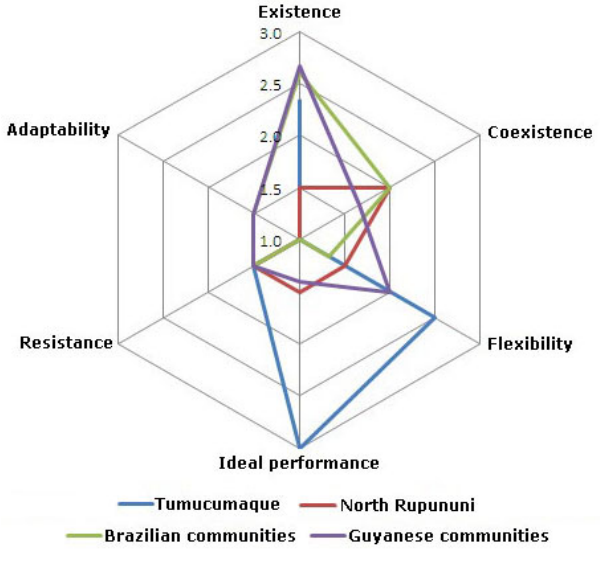
Fig. 3 . Star diagram showing average values for each system property at each scale of